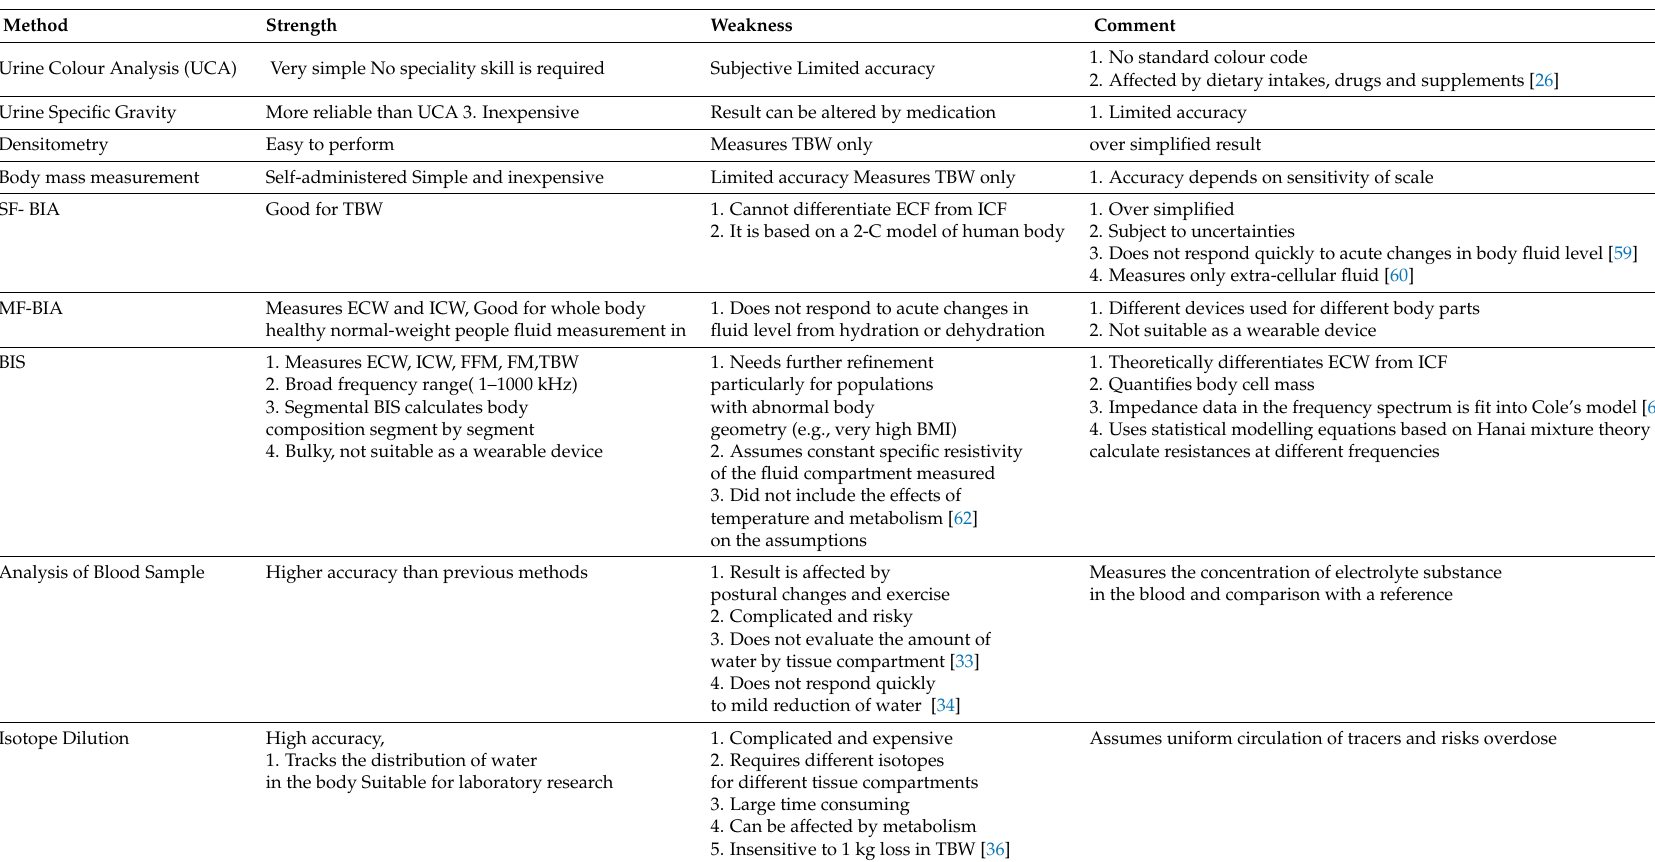
Table 1. Summary of body fluid assessment techniques. SF-BIA: Single-frequency bioelectrical impedance); MF-BIA: multi-frequency bioimpedance analysis; BIS: bioimpedance spectroscopy; TBW: Total body water; ECW: extracellular water; ICW: intracellular water; FFM: fat free mass; FM: fat mass; ECF: extracellular fluid; ICF: intracellular fluid; BMI: body mass